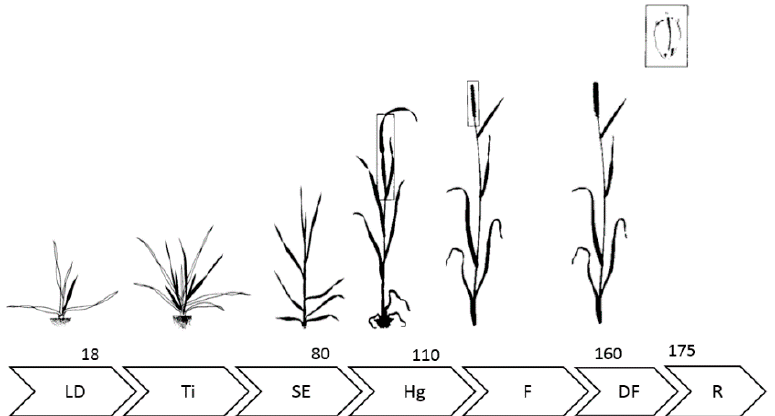
Figure 2. Temporal evolution, expressed in day of year (DOY), of the main crop phenological stages according to Lancashire et al. [23]. The meaning of their acronyms is indicated in Table 1.